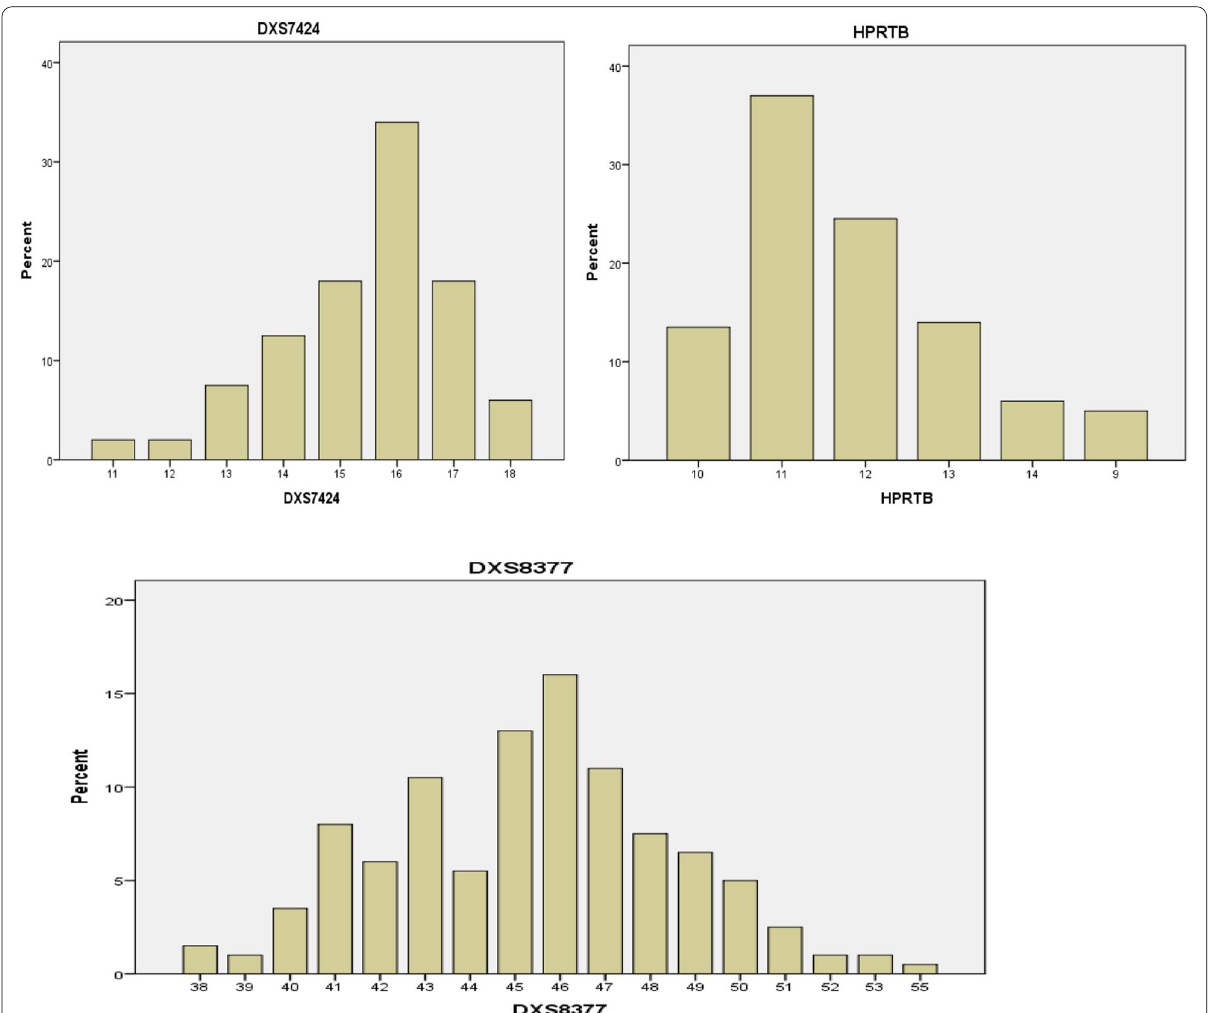
Fig. 2 The percent distribution of allele frequency of the first group (DXS7424, HPRTB, and DXS8377)